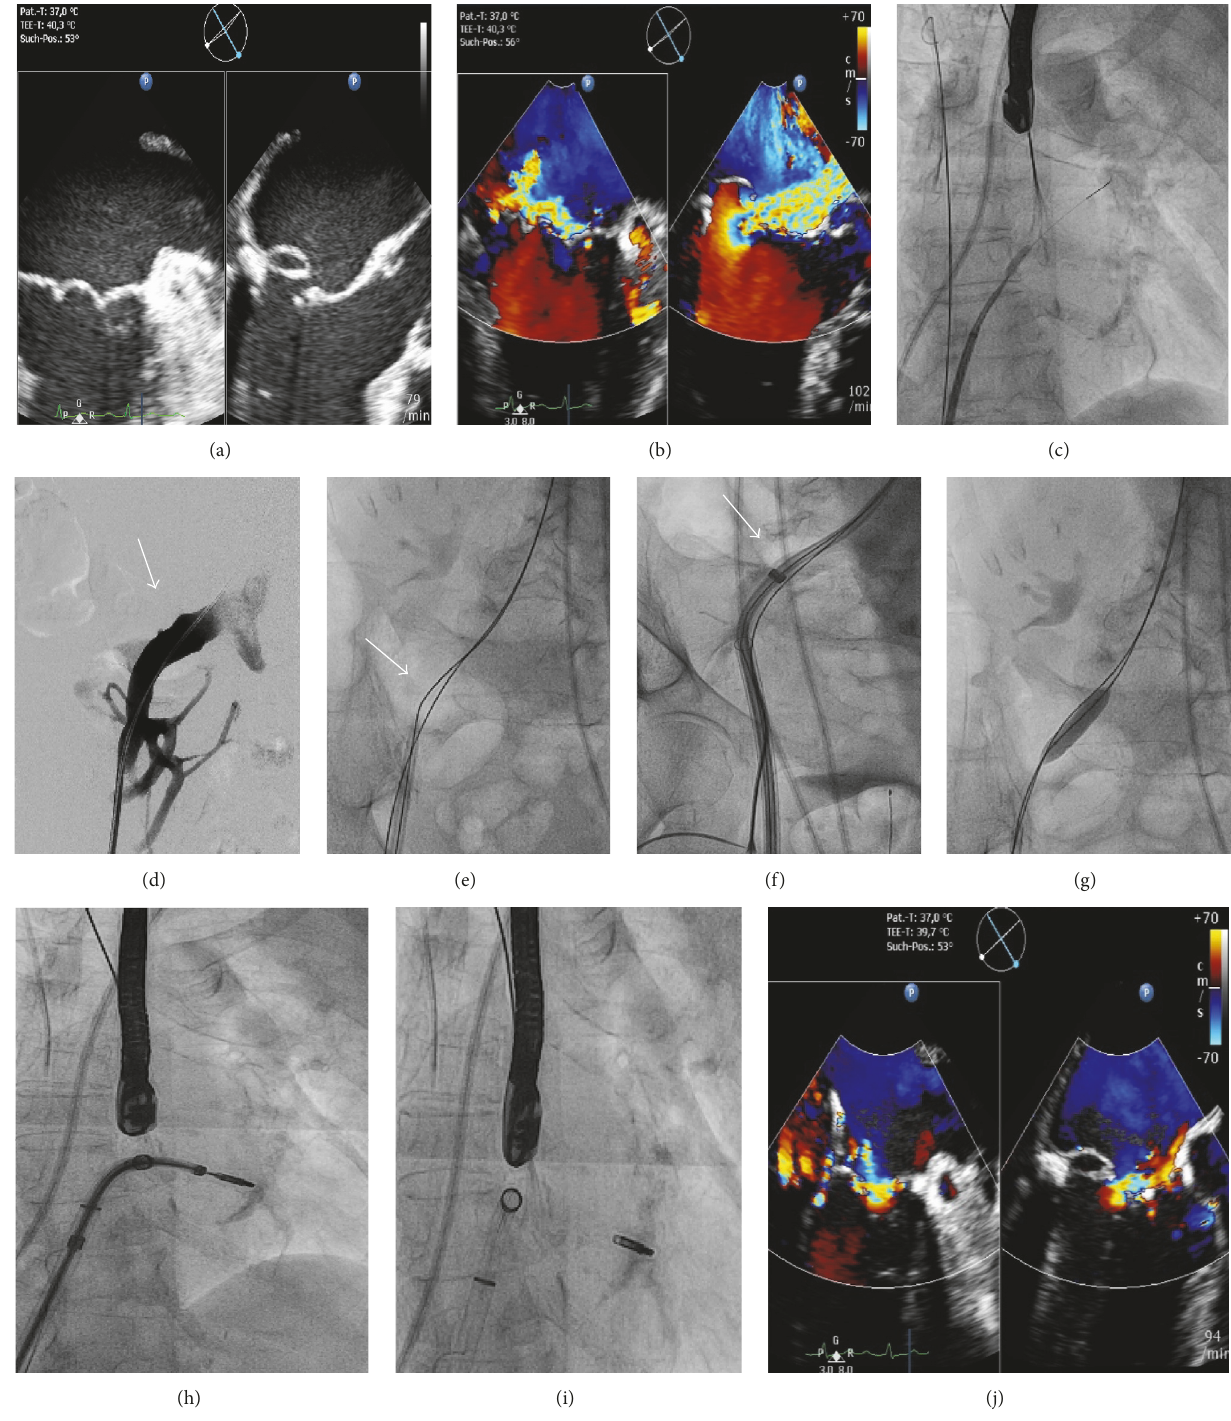
Figure 1: Images of transesophageal echocardiography (TEE) and fluoroscopy during percutaneous edge-to-edge mitral valve repair (PMVR) . (a) The biplane intercommissural and left ventricular outflow tract (LVOT) view in TEE showing a severe prolapse and flail of the posterior mitral leaflet(PML;P2segment).(b)ThebiplaneintercommissuralandLVOTviewinTEEwithcolorDopplerdemonstratingeccentricseveremitral regurgitation (MR). (c) Fluoroscopy showing balloon dilatation of the interatrial septum over a transseptal guidewire. (d) Digital substraction angiography (DSA): a mechanical obstruction in this area with a tortuous right common iliac vein precluded advancement of the MitraClip system (the depicted arrow may indicate a venous valve). (e) Fluoroscopy showing an unsuccessful attempt to dilate the right iliac vein with a dilator. (f) Unsuccessful attempt to advance the guide through the iliac vein (the arrow indicates an obstruction at the curve of the right common iliac vein). (g) Dilatation of the right iliac vein with increasing sizes of percutaneous transluminal angioplasty (PTA) balloons (up to 10mm). (h) Successful positioning of the MitraClip delivery system and the clip within the left atrium. (i) Clip deployment. (j) Significant reduction of MR after clip deployment as demonstrated by intraprocedural